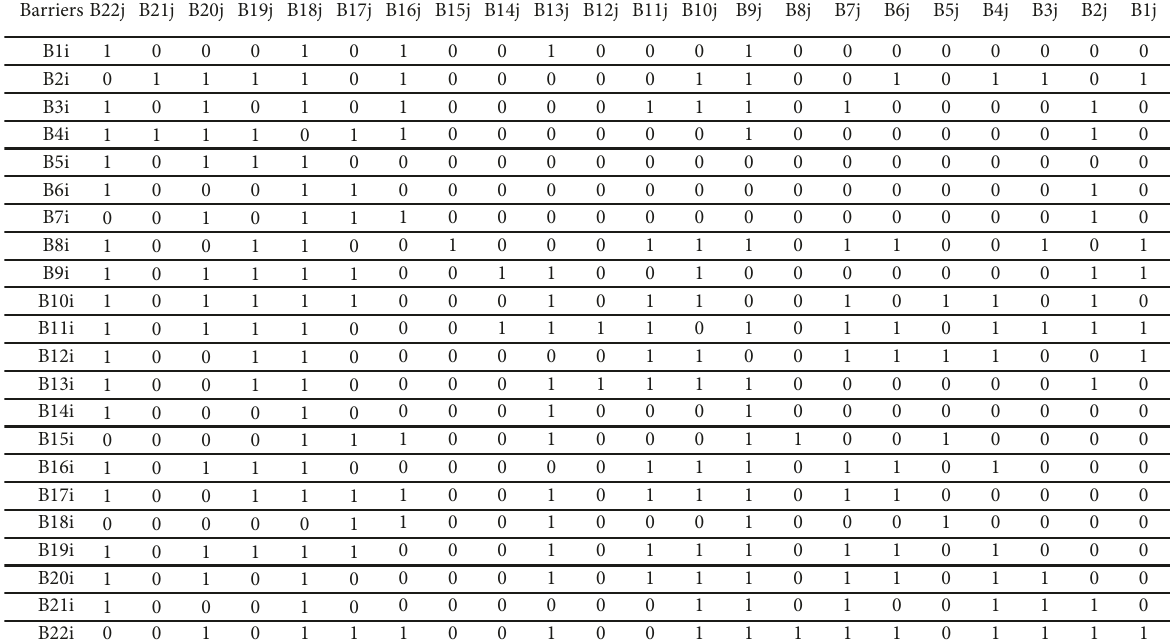
Table 9: Combined initial reachability matrix.